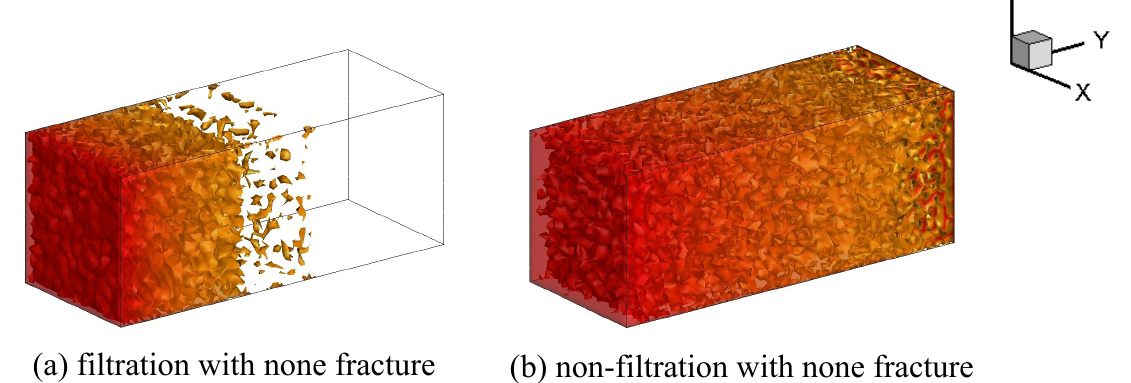
Figure 10. Grout penetration in a porous medium.